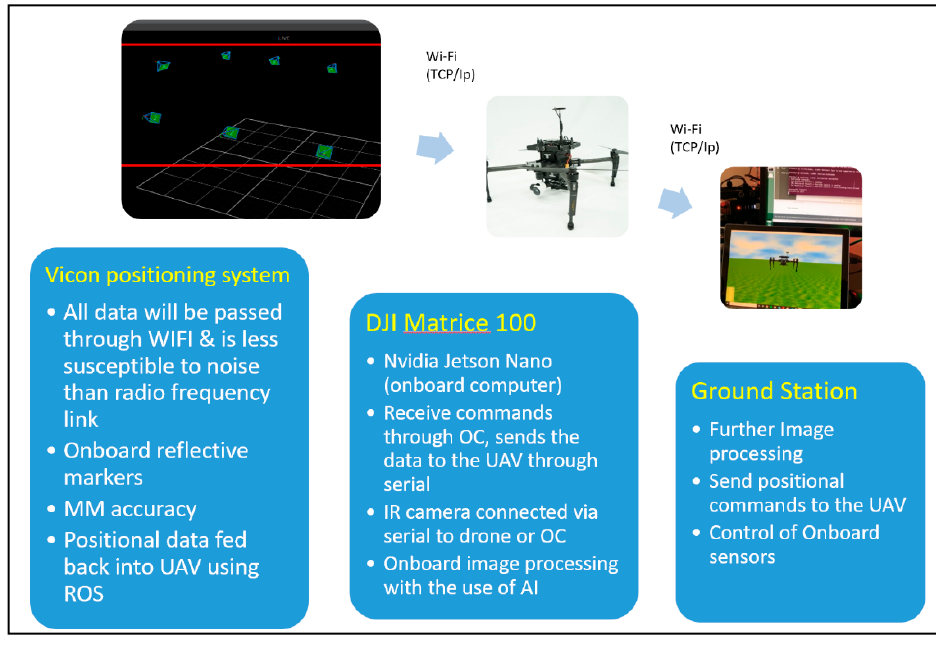
Figure 24. Flow chart of the indoor inspection process.